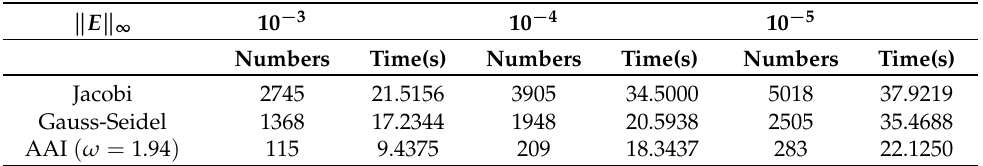
Table 4: The convergence rates and errors